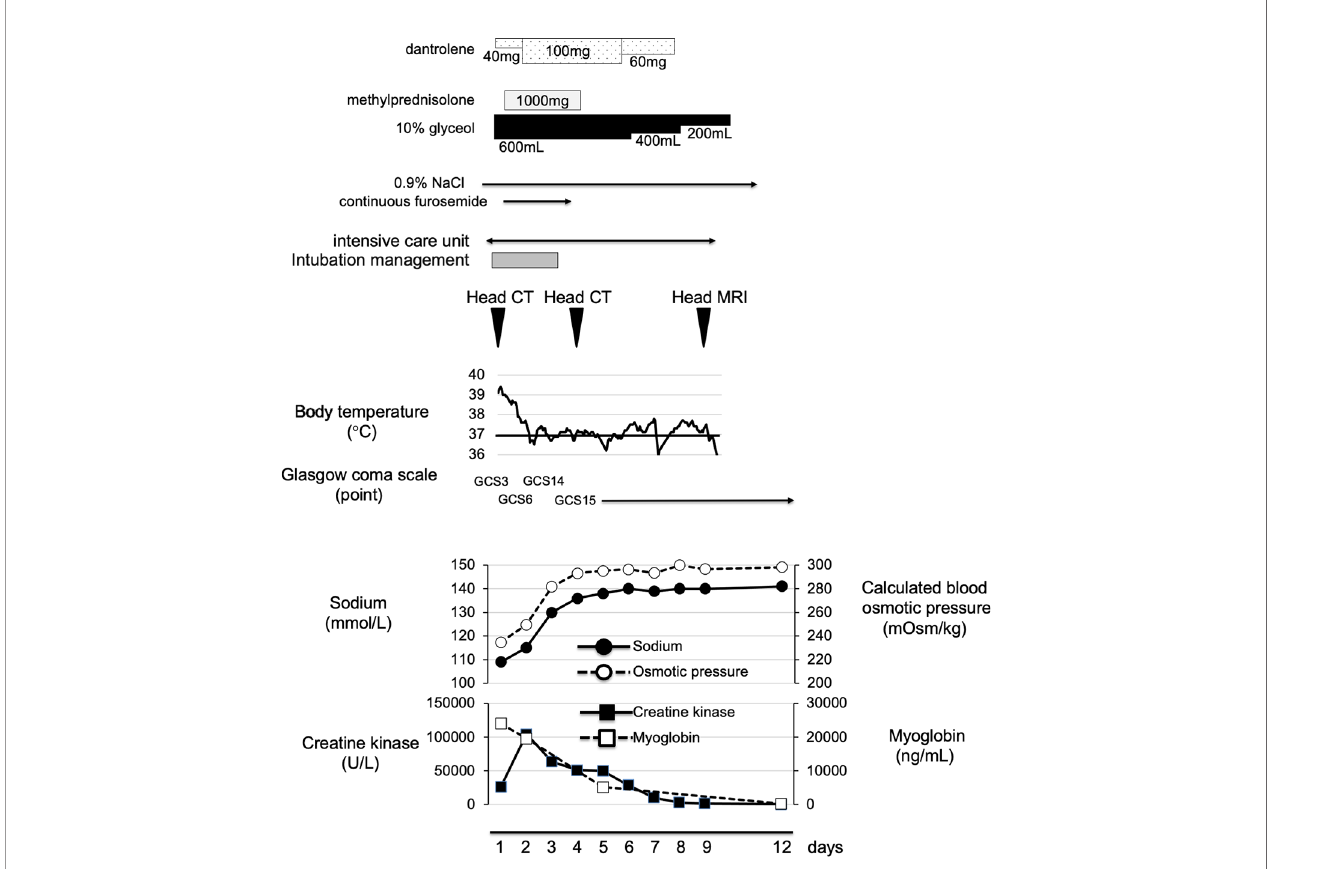
FIGURE 3 | Time course of clinical parameters in this subject. On admission, we started fl uid management, by using 10% glyceol and methylprednisolone for cerebral edema and dantrolene for NMS. His body temperature and coma were improved together with correction of hyponatremia and cerebral edema. He was transferred from HCU to general ward at day